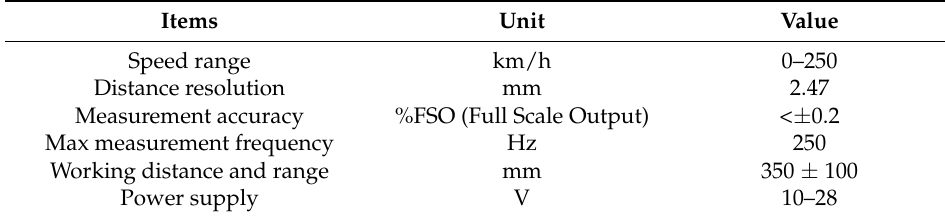
Table 2. Performance specifications of S-350 sensor.